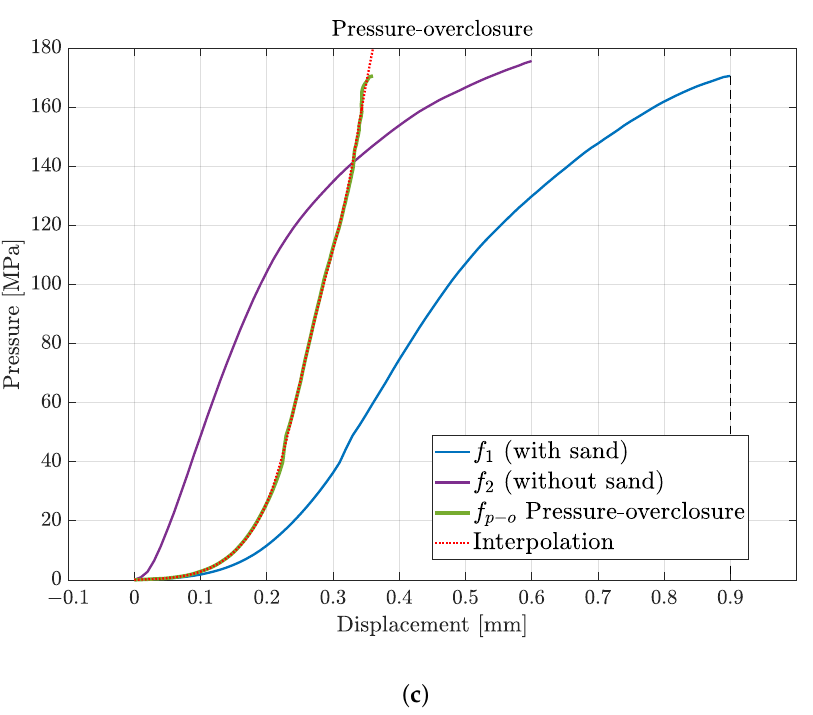
Figure 7. Experimental determination of the pressure-overclosure condition. ( a ) Test set for the compression test; ( b ) PA6GF30 plate under the sand-coated CFRP lamella disk: the plate failed at high compressive stresses; ( c ) pressure-overclosure condition for the configuration shown in ( a